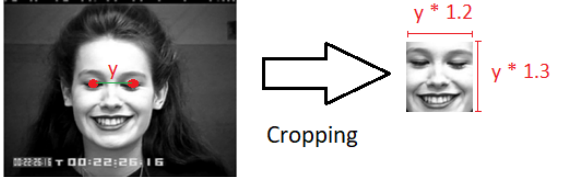
Figure 9. Background removal using the distance between eyes of a face from the CK+